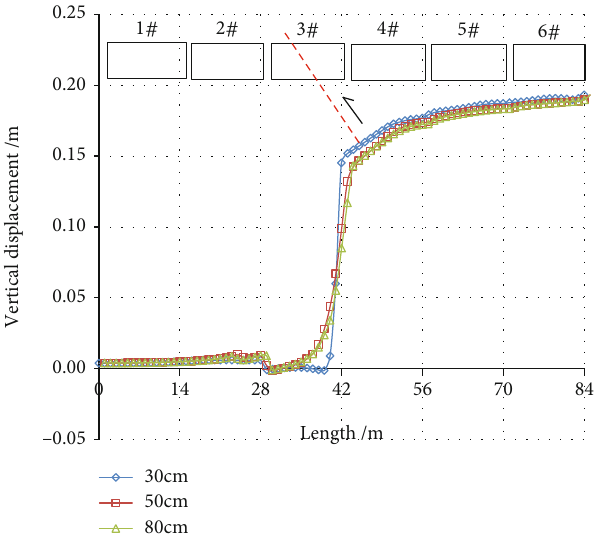
Figure 10: Vertical deformation curves of the inverted arch of di ff erent thicknesses under fault